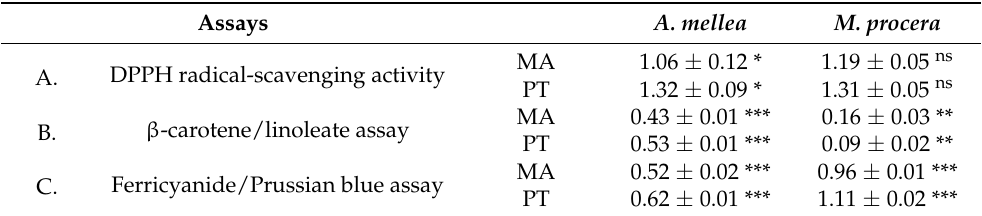
Table 4. IC 50 (mg/mL) of antioxidant properties of the methanolic extracts from Northern Morocco (MA) and Portugal